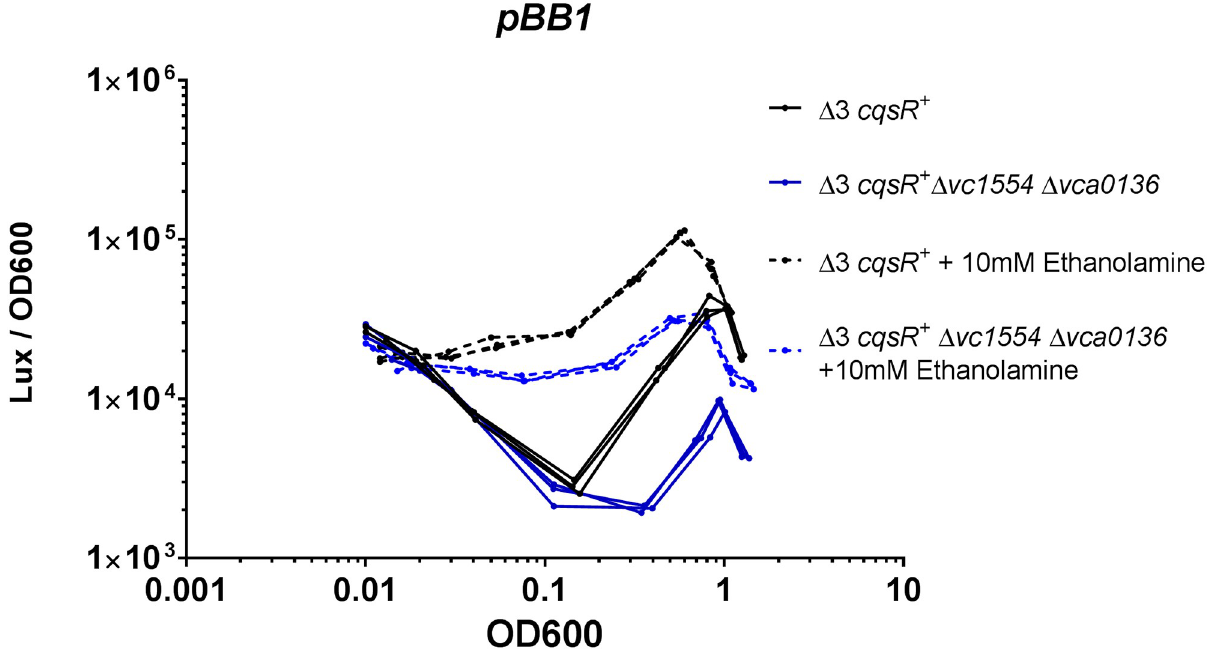
Fig 7. Effect of glycerophosphodiesterase deletions on CqsR quorum-sensing response. HapR-dependent bioluminescence profiles (lux/OD 600 ) were measured in a Δ 3 cqsR + strain and an isogenic strain with deletions in loci vc1554 and vca0136 , encoding the two putative glycerophosphodiester phosphodiesterases in LB medium and in the presence of 10 mM ethanolamine. The figure shows a representative profile of each condition with two biological replicates. Each experiment was performed independently at least two times.